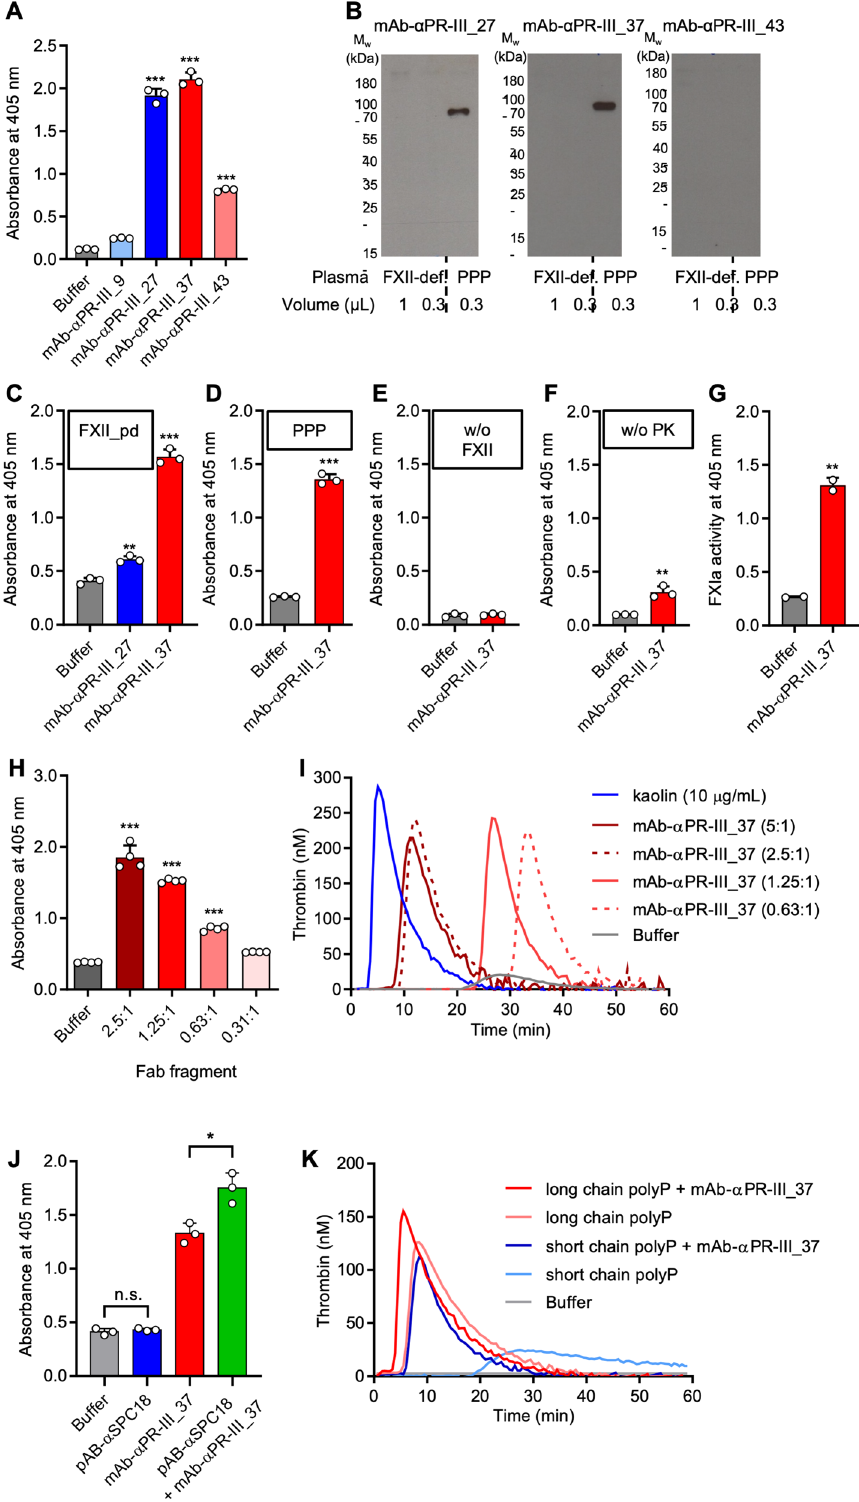
trypsin inhibitor (2 µM) to background levels. Supporting the speci fi city of mAb- α PR-III_37 in activating FXII in plasma, the magnitude of antibody-stimulated FXIIa correlated with plasma FXII zymogen levels (Supplementary Fig. 6B). Additionally, western blotting revealed that mAb- α PR-III_37 initiated FXII zymogen cleavage in plasma dose-dependently. In PK-de fi cient plasma, fl uid phase activation and reciprocal FXII(a)/PK(a)